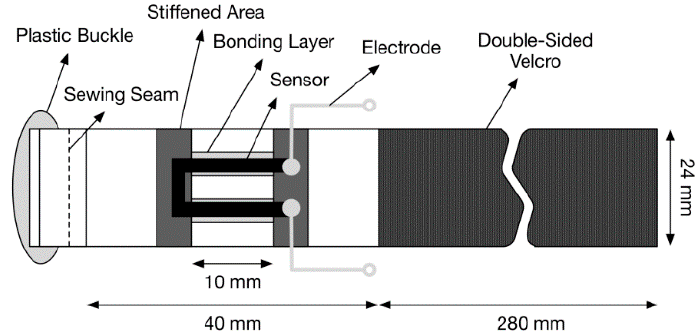
Figure 4. Schematic description of the wrist-mounted band sensor for motion and pulse wave capture.